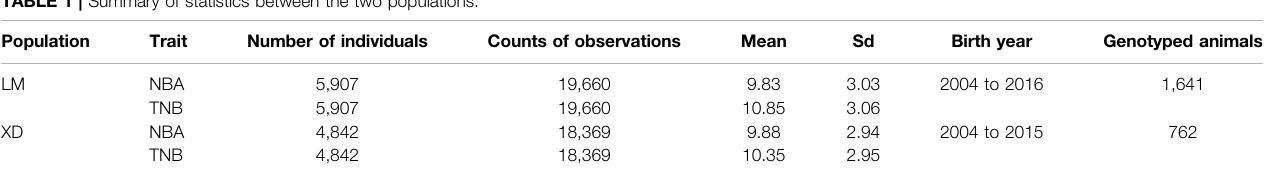
TABLE 1 | Summary of statistics between the two populations. Population Trait Number of individuals